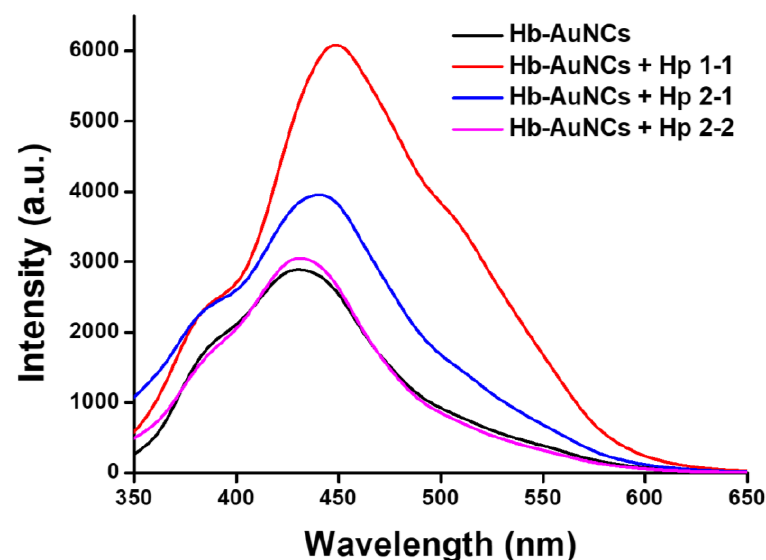
Figure 7. Fluorescence spectra of hemoglobin-conjugated gold nanoclusters (Hb-AuNCs) before and after adding Hp 1-1, Hp 2-2, and Hp